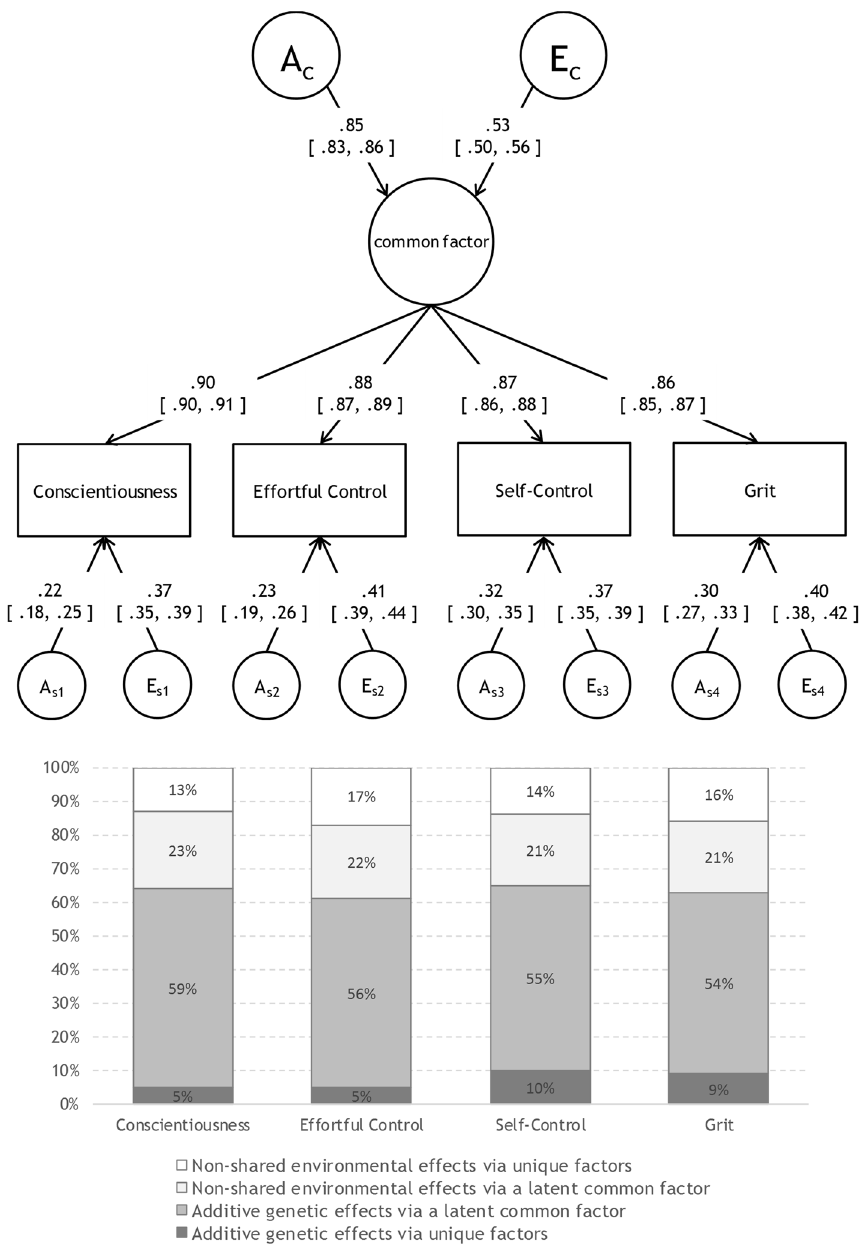
Figure 2. AE common pathway model for conscientiousness-related measures with standardised estimates (and 95% confidence intervals) alongside bar charts for the percent variance